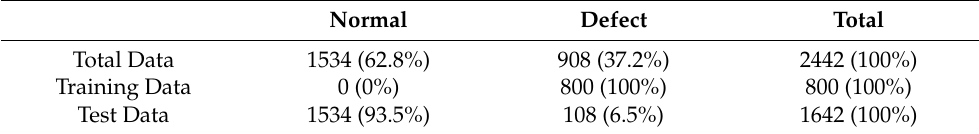
Table 2. Dataset for training and test.